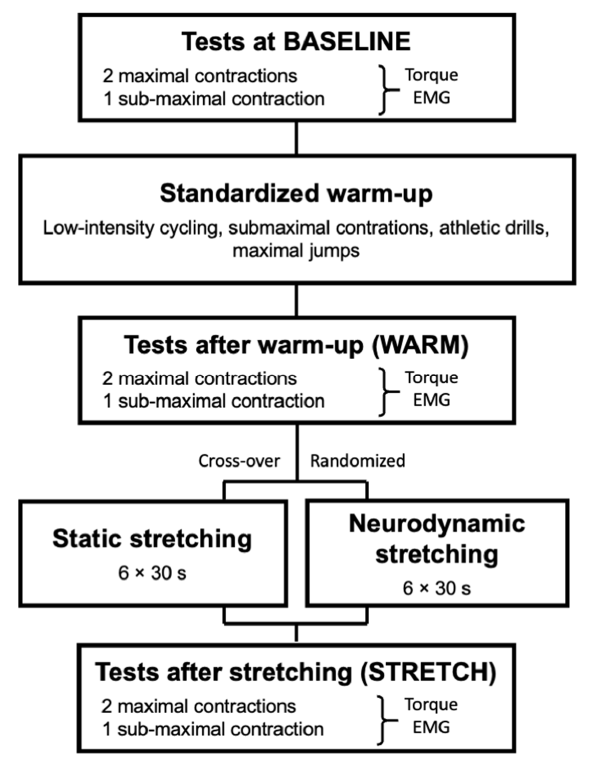
Figure 1. Overview of the two experimental sessions.